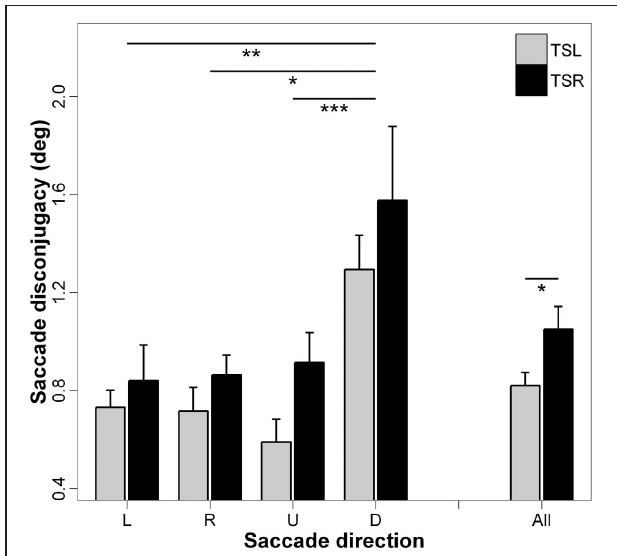
FIGURE 7 | Mean values of saccade disconjugacy for each saccade direction (L, leftward; R, rightward; U, upward; D, downward) and tinnitus side (TSL, tinnitus side left; TSR, tinnitus side right). Error bars represent the standard error. The symbol ∗ indicates a statistically significant effect ( ∗ p < 0 . 05; ∗∗ p < 0 . 01; ∗∗∗ p < 0 . 001).